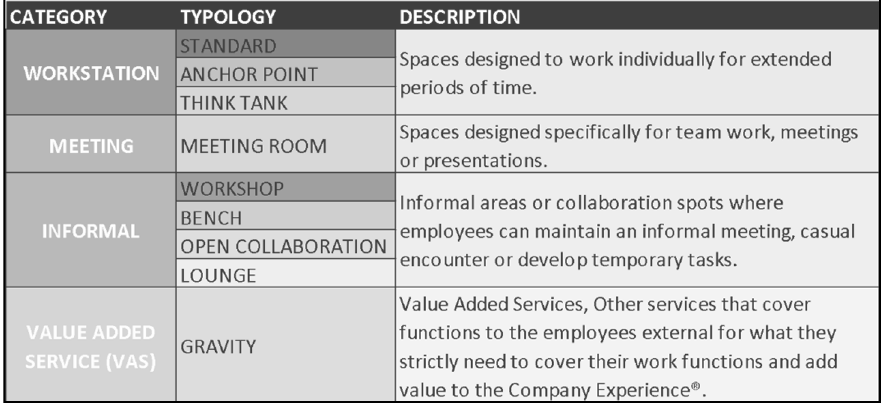
Figure 4. Office space classification.